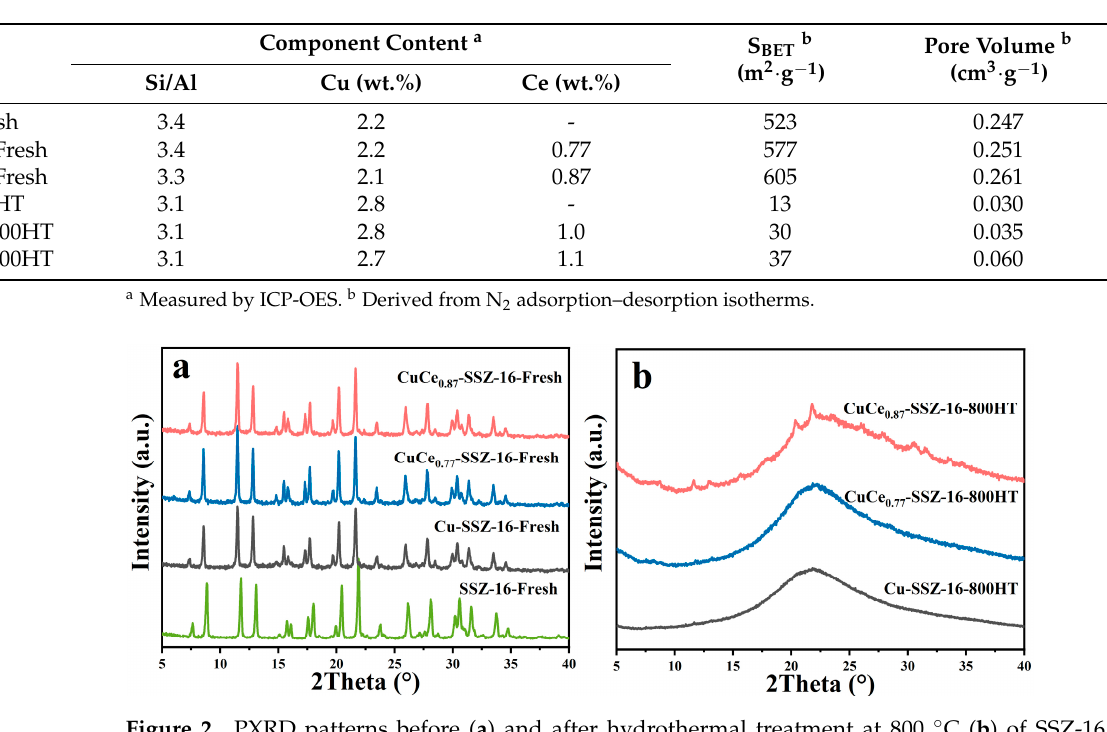
Figure 2. PXRD pa tt erns before ( a ) and after hydrothermal treatment at 800 °C ( b ) of SSZ-16, Cu- SSZ-16, CuCe 0.77 -SSZ-16, and CuCe 0.87 -SSZ-16. Cu-SSZ-16, CuCe 0.77 -SSZ-16, and CuCe 0.87